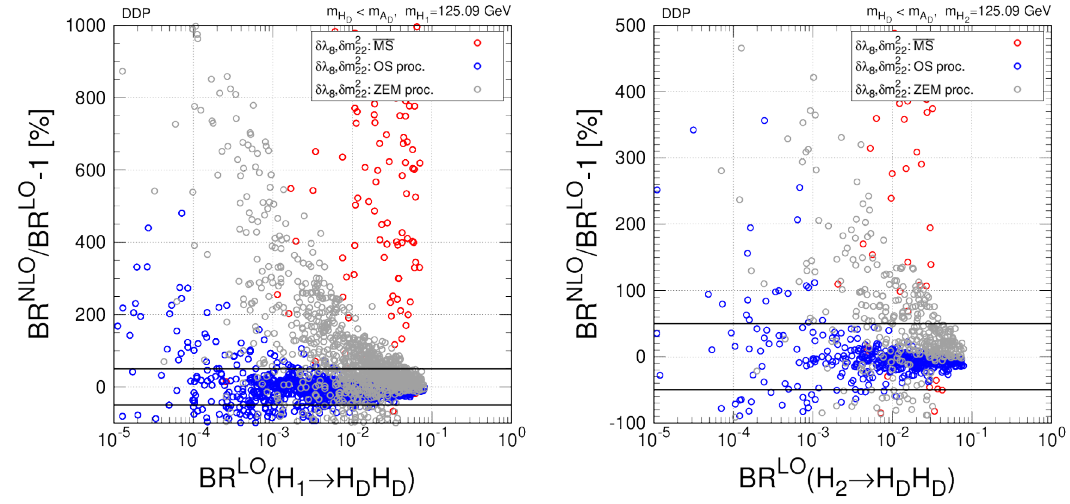
Figure 6 . Ratio of NLO to LO corrections for BR( H i → H D H D ) in scenario 1 (left) and scenario 2 (right). The red, blue and grey points correspond to the MS , ZEM process-dependent and OS process-dependent scheme, respectively. The black horizontal lines correspond to BR NLO / BR LO − 1 = ± 50%